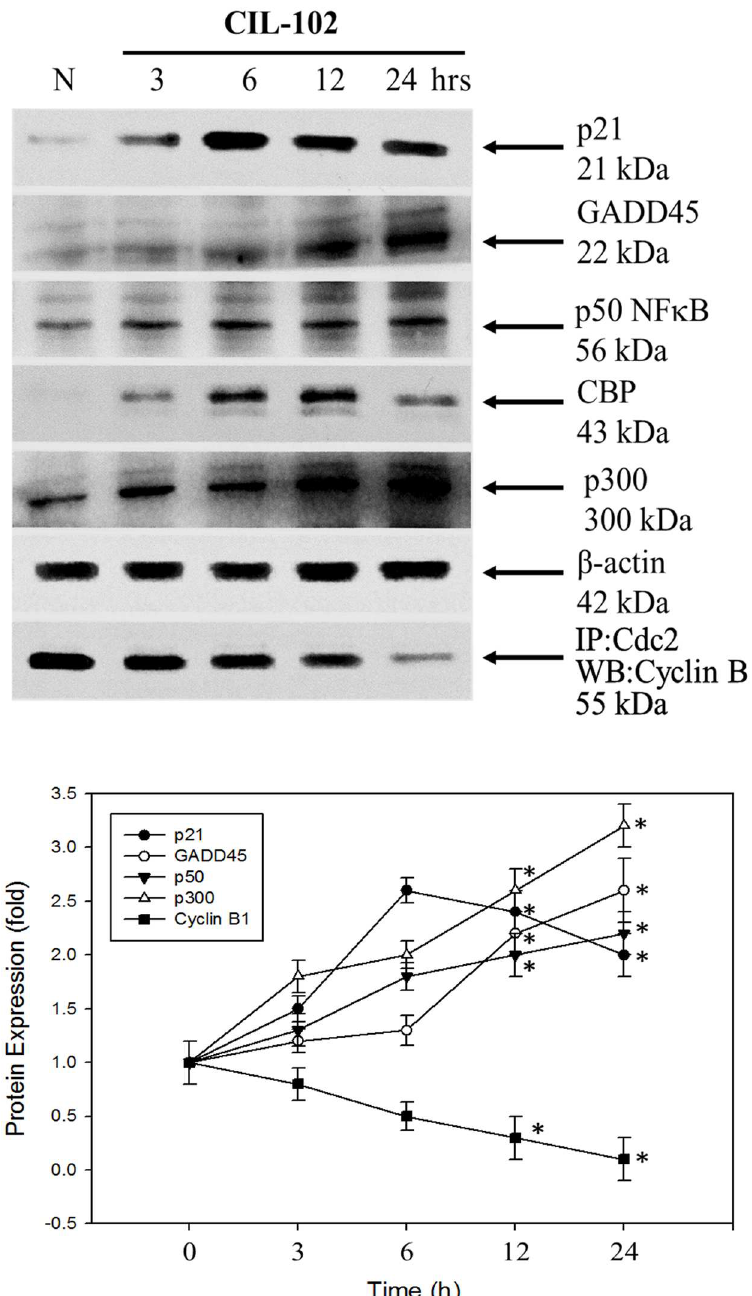
Fig 5. Effect of CIL-102 on the p21, GADD45, p50 NF κ B, p300/CBP, CREB as well as expression of cell cycle associated proteins. DLD-1 cells were pretreatedwith CIL-102 for indicatedtime points. Whole cell lysate proteins were preparedand analyzedby western blot, with β -actinserving as loadingcontrol. CIL-102 for the indicatedtimes were analyzedby 10% SDS-PAGE and subsequently treated with antibodiesagainst p21, GADD45,p50 NF κ B, p300/CBPand CREB. The association of cdc2 with Cyclin B were determinedby immunoprecipitation followedby western blot with